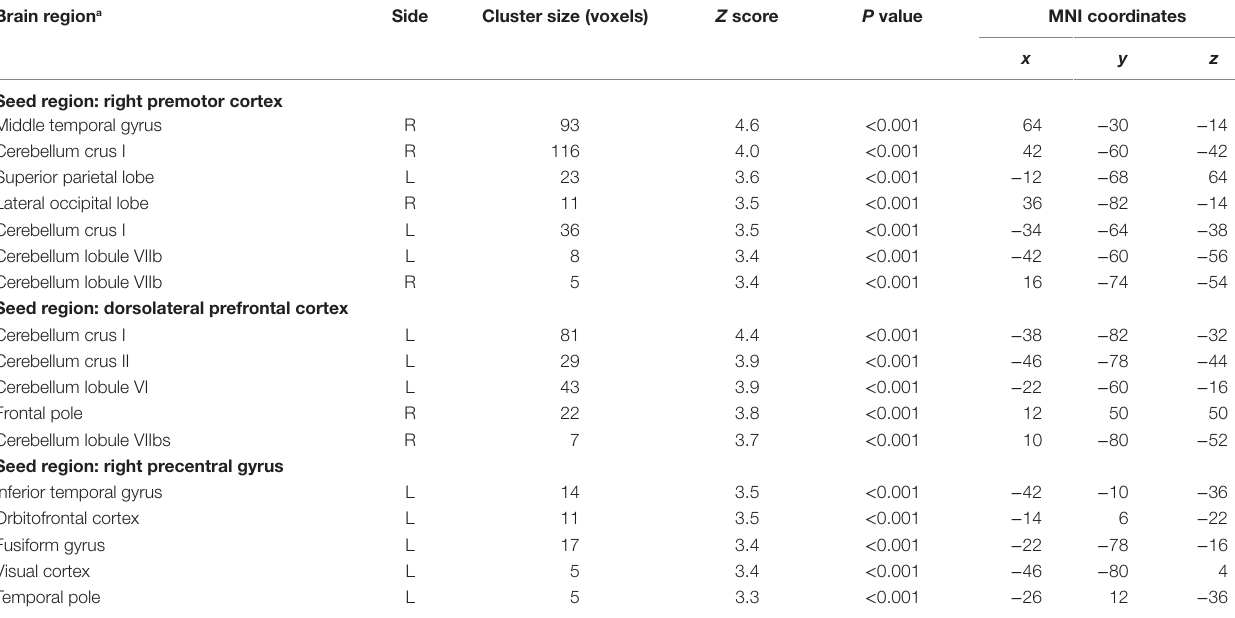
TaBle 4 | The brain regions where functional connectivity of the seed regions was positively correlated with the masticatory performance index. Brain region a side cluster size (voxels) Z score P value